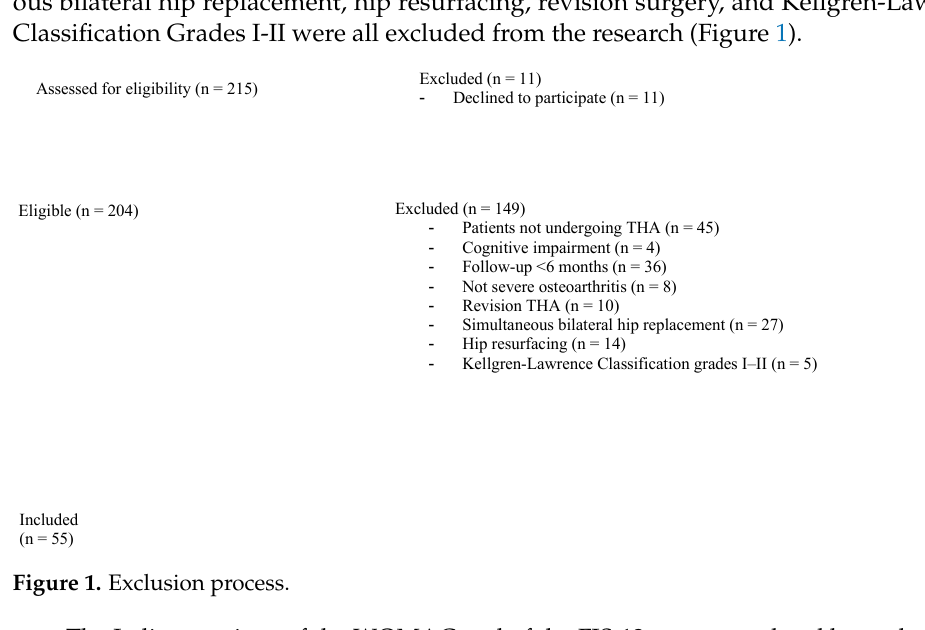
Figure 1. Exclusion